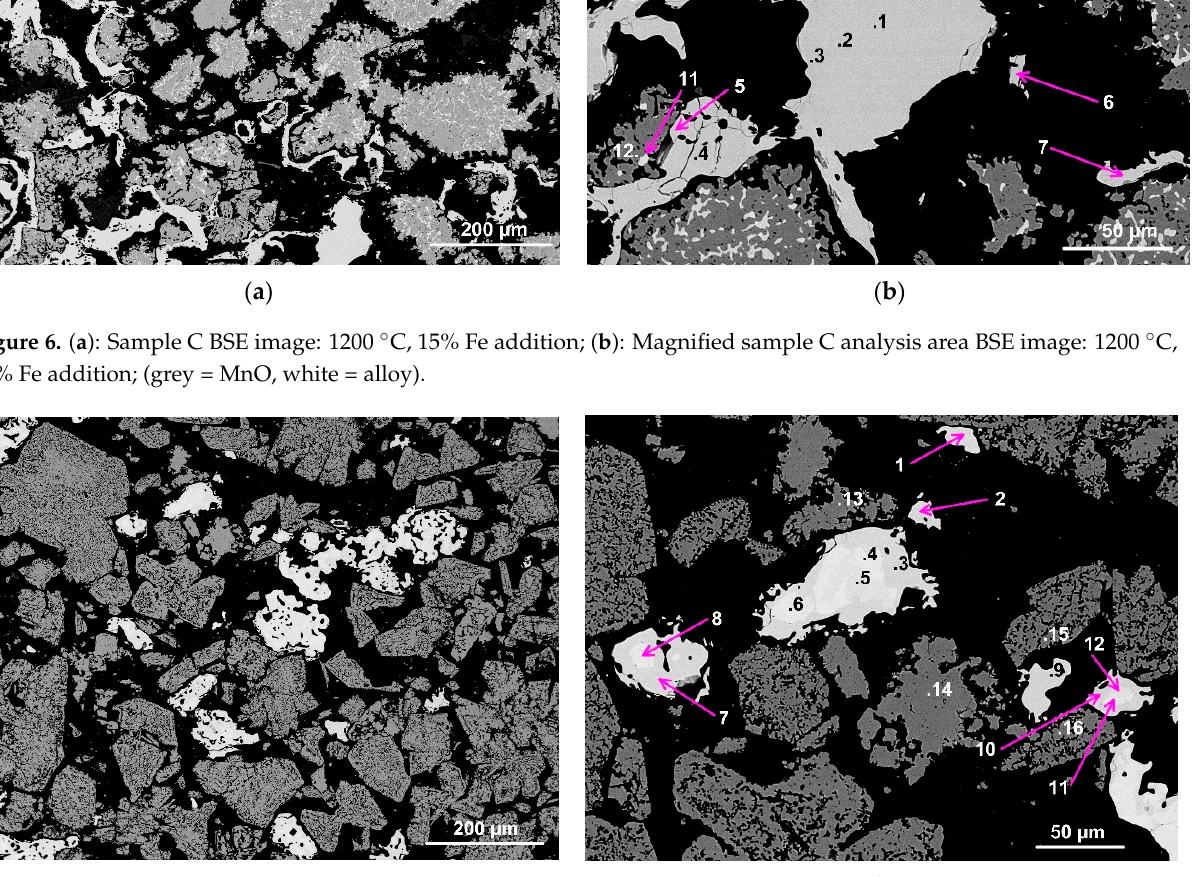
Figure 6. ( a ): Sample C BSE image: 1200 °C, 15% Fe addition; ( b ): Magnified s ample C analysis area BSE image: 1200 °C, 15% Fe addition; (grey = MnO, white = alloy). Table 3. SEM-WDS analyses of points in Figure 6b.